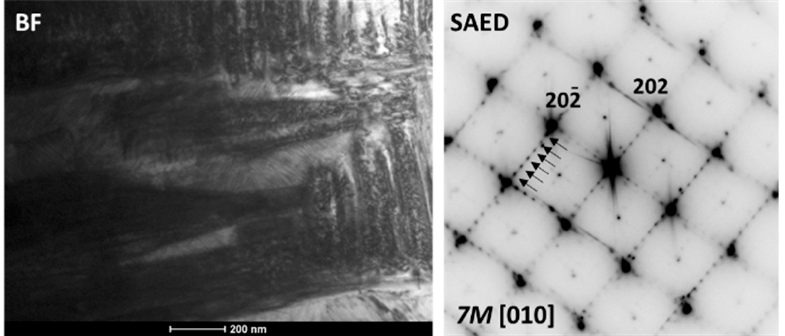
Figure 9. Bright field (BF) and the corresponding selected area electron diffraction (SAED) of as laser melted Ni-Mn-Ga-Fe powder taken from an area dominated with the 7M martensite phase.